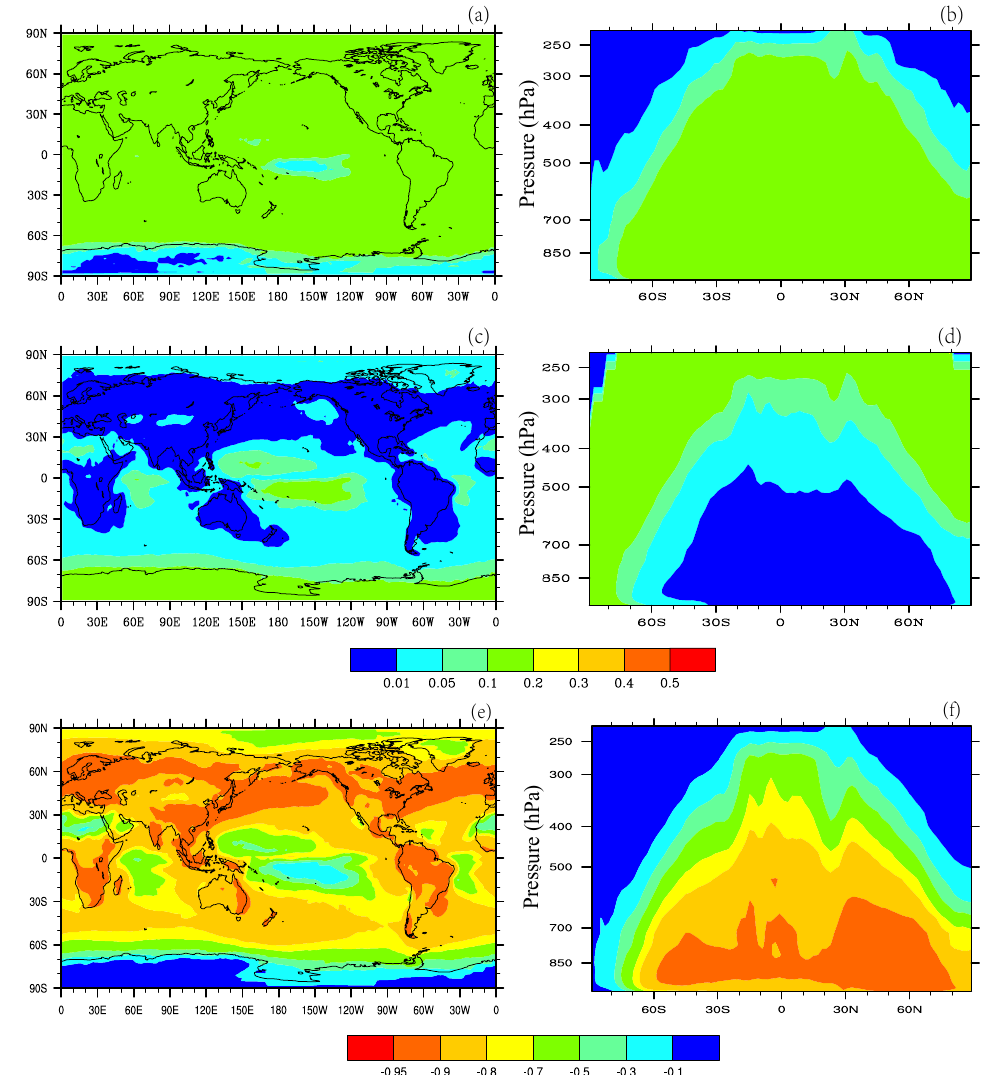
Fig. 5. Relative change of annual averaged column (a, c, e) and zonal mean (b, d, f) production of SOA cld as a result of 20% increase in parameter α (a, b) , β (c, d) , and γ (e, f)